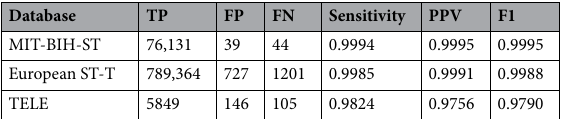
Table 4. The summary of the model performance in MIT-BIH-ST, European ST-T, and TELE